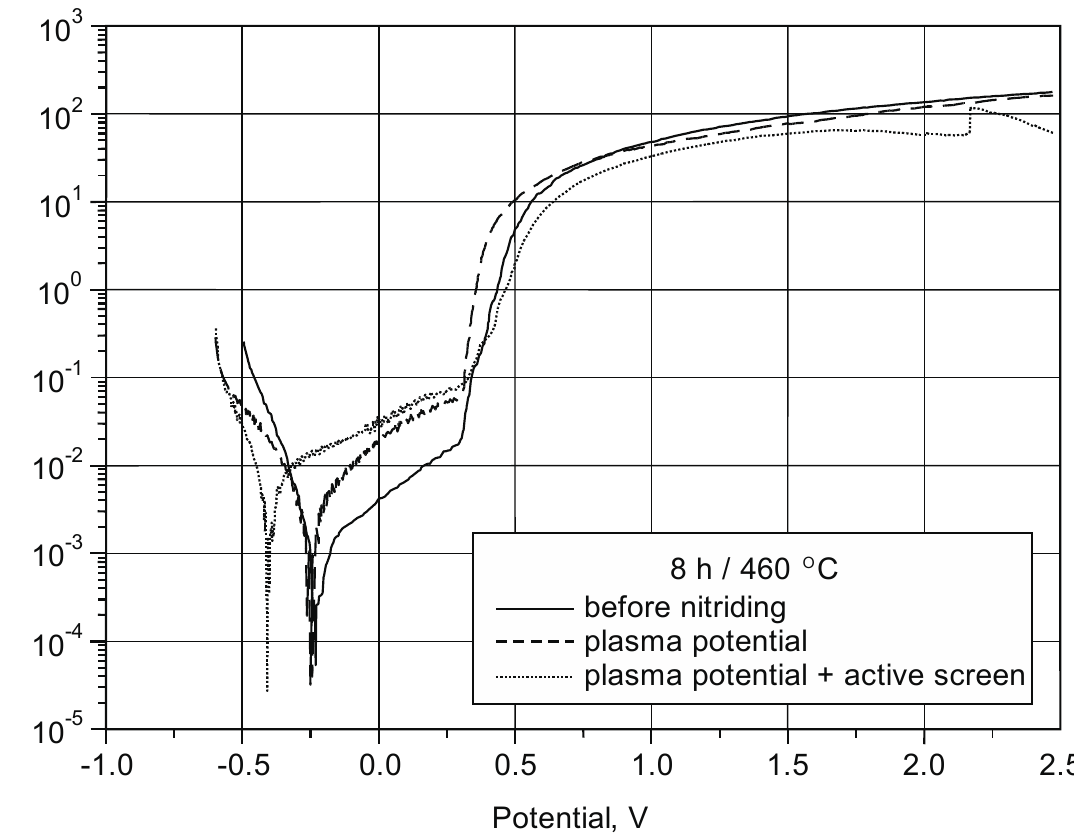
Figure 10. Potentiodynamic curves of the tested layers of 316L steel before and after nitriding in different variants.